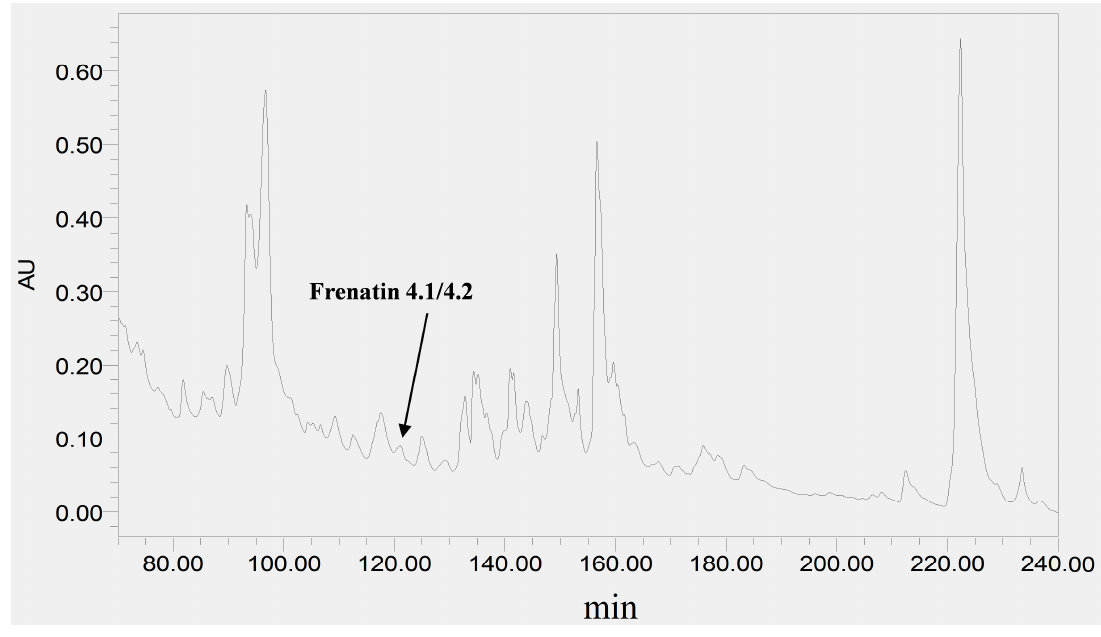
Figure 2. Region of RP-HPLC chromatogram of L. infrafrenata skin secretion with an arrow indicating the elution position/retention time of both frenatin 4.1 and its natural post-translationally modified analogue, frenatin 4.2.